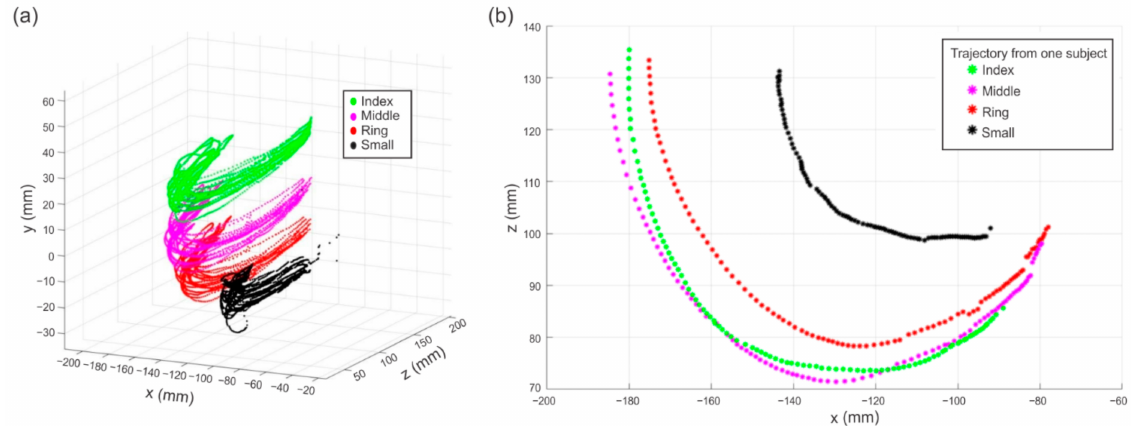
Figure 13. Trajectories for flexion–extension from index to small, ( a ) xyz spatial representation, ( b ) xz planar representation of one